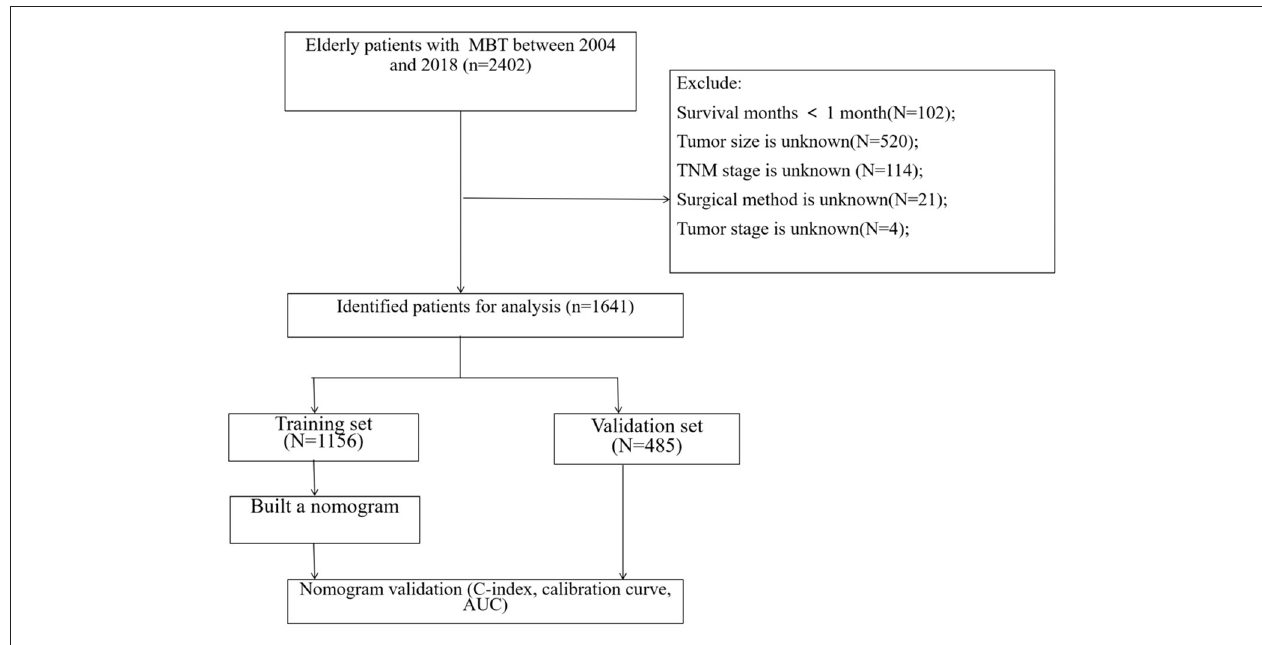
FIGURE 1 | The flowchart of including and dividing